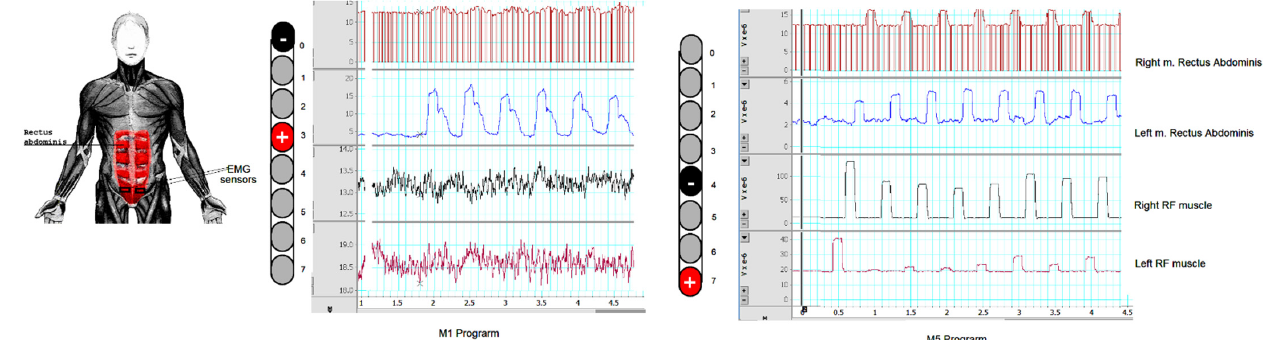
Figure 7. The EMG responses of the right and left rectus abdominis muscle and right and left rectus femoris muscles. A single lead approach was adopted for MI ( − 0 and +3) and M5 ( − 4 and +7) with a frequency of 2 Hz, pulse duration of 240 µs, and 6 volts. EMG sensors were placed at the distal 1/3 of the rectus abdominis. It is worth noting that there was no EMG activity detected below 6 volts. M1 resulted in a reasonable isolation of the rectus abdominus muscles from the rectus femoris muscles whereas M5 resulted in bilateral stimulation of the rectus femoris muscles with activation of the rectus abdominis muscles.